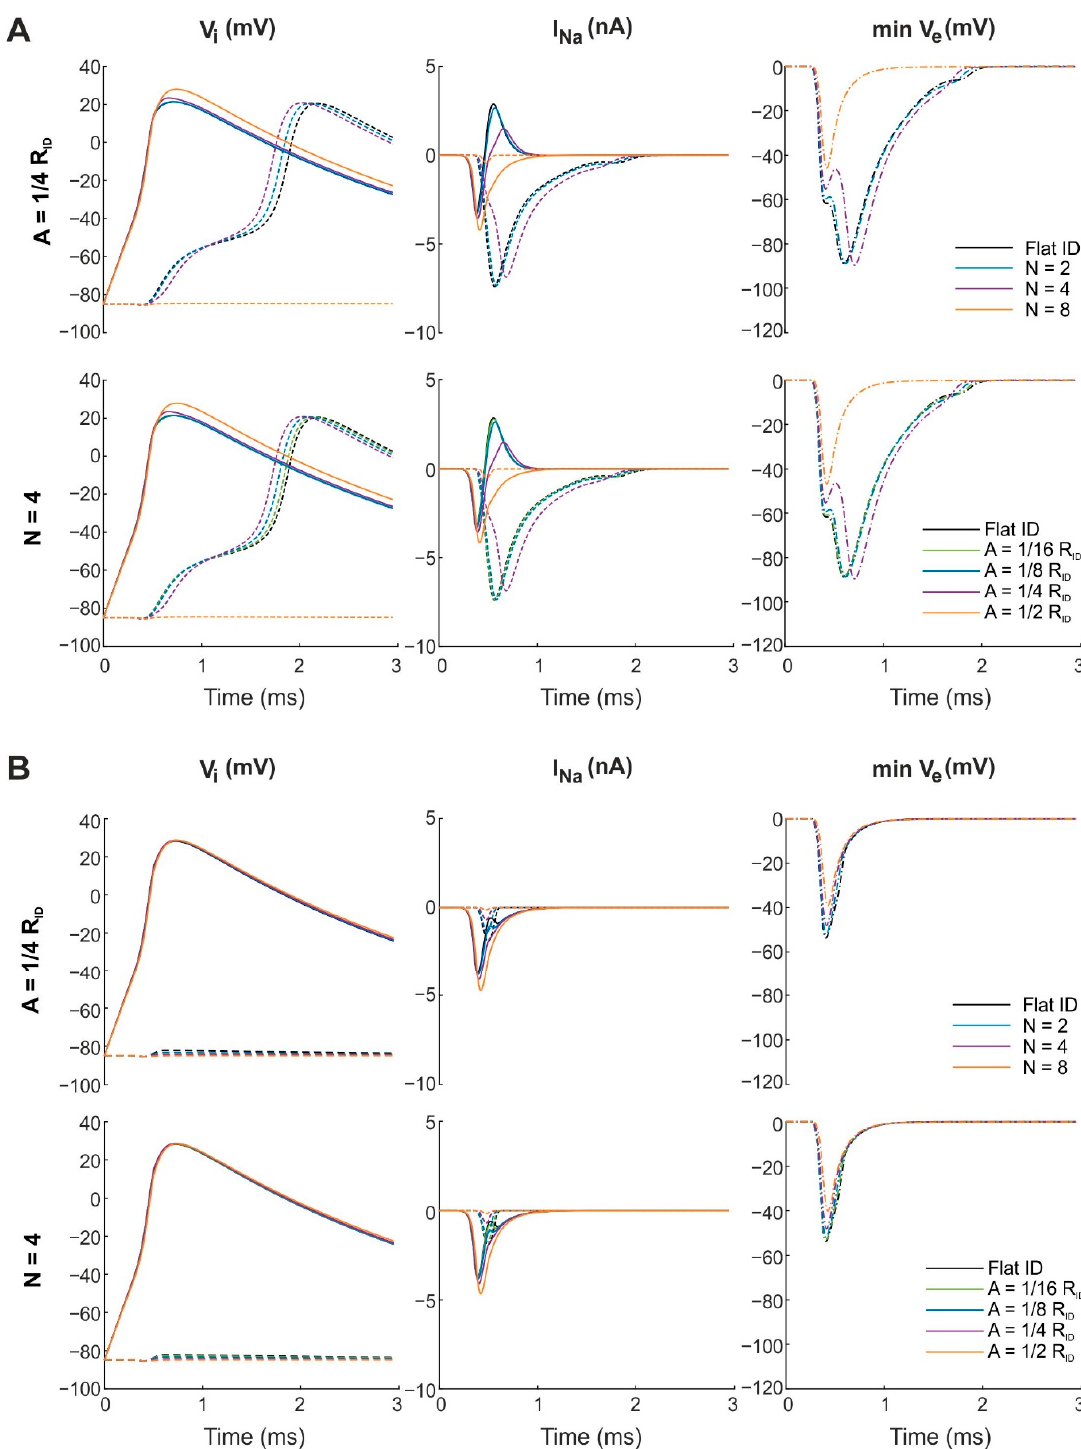
Figure 7 . Effects of changing the number N and amplitude A of radial folds on V i , I Na and minimal V e with Na + channels clustered in the center of the intercalated disc (R c = 1/8 R ID ). Contains the same simulations and figure layout as in Figure 6 but now shows results for an intercalated disc mesh with radial folds. ( A ) The cleft width was set to 30 nm. First row: The amplitude of the folds was kept constant (A = 1/4 R ID ) while the number of folds N was varied from 2 to 4. Second row: The number of folds was kept constant (N = 4) while their amplitude A was varied from 1/16 R ID to 1/2 R ID . ( B ) The cleft width was set to 40 nm. Number and amplitude of folds were varied as in panel A .